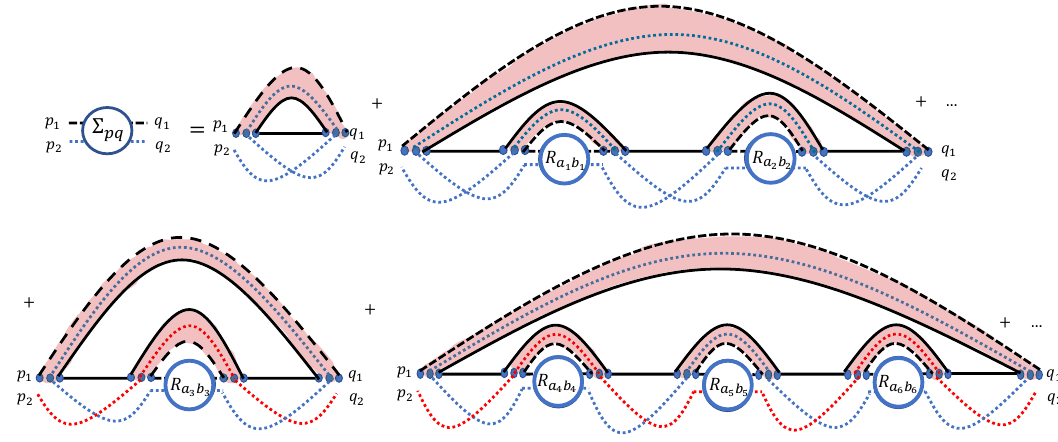
Figure 24 . Rewriting of the r.h.s. of figure 23(b) as a Schwinger-Dyson equation. All a i , b i are independently summed over (unless they have delta functions among each other or with p, q according to the